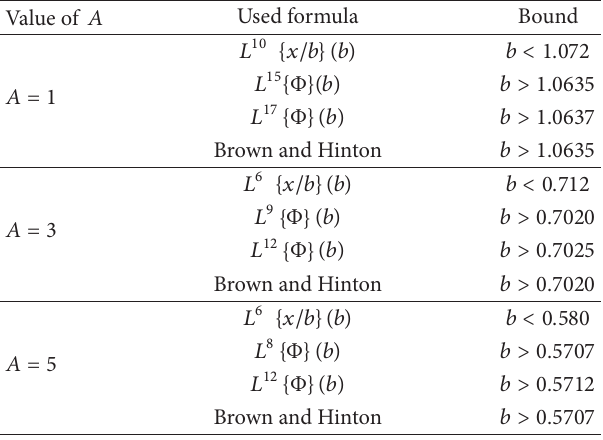
Table 1: Comparison of bounds for 𝑏 in Example 1.